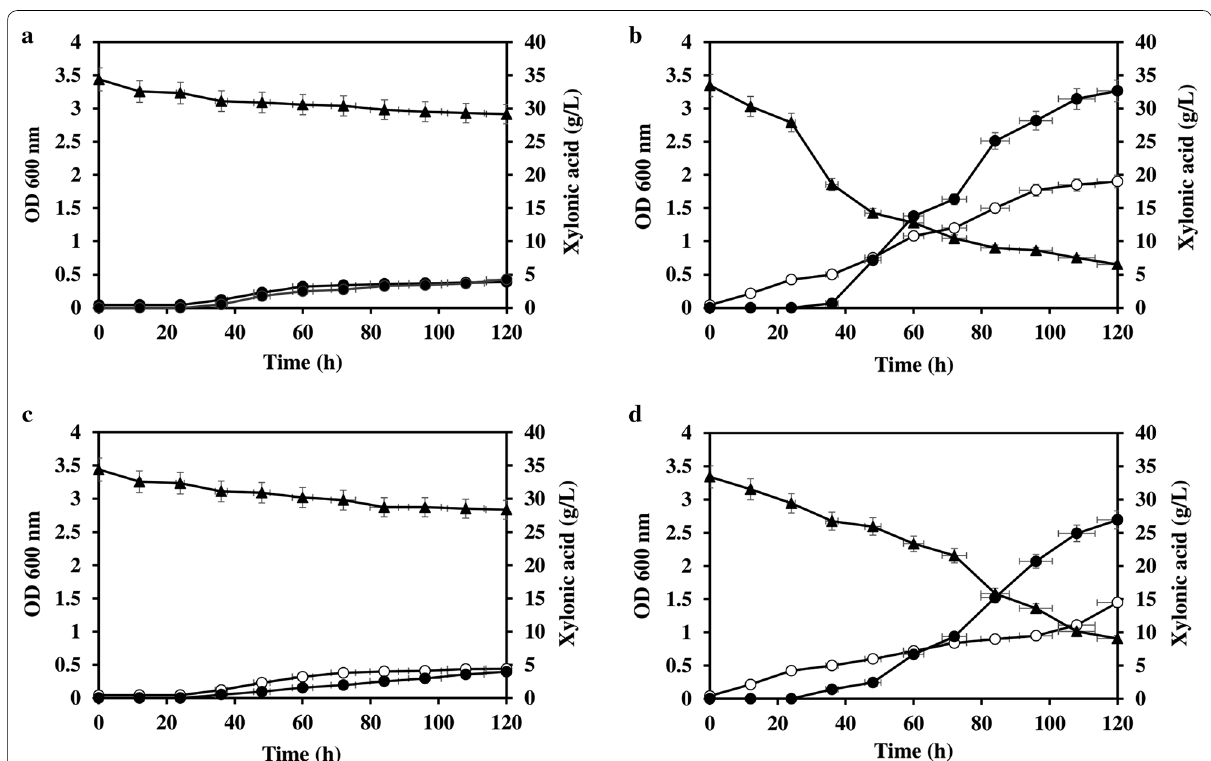
Fig. 1 Xylose consumption (35 g/L) ( closed triangle ), xylonic acid production (closed circle) and growth curve (open circle) of C. glutamicum ATCC 31831 ( a ) pVWEx1 ( b ) pVWEx1- xyl B ( c ) pVWEx1- xylC ( d ) pVWEx1- xyl BC